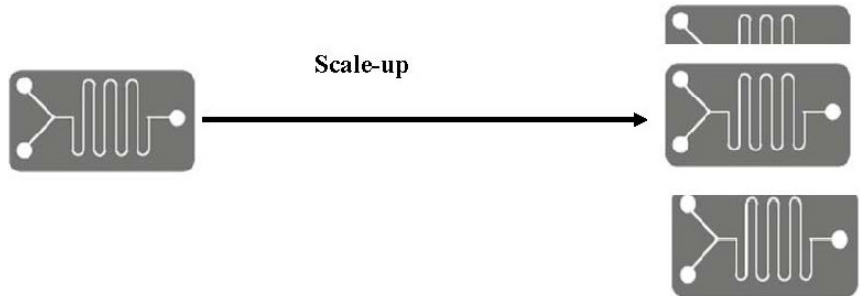
Figure 2. Schematic of scale-up of microfluidic